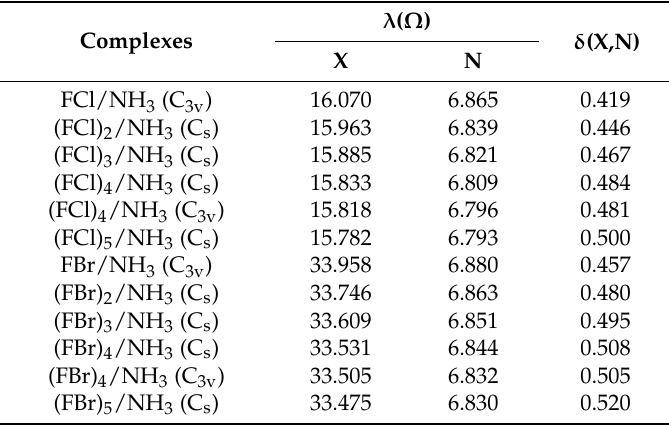
Table 3. Electronic localization and delocalization indices.